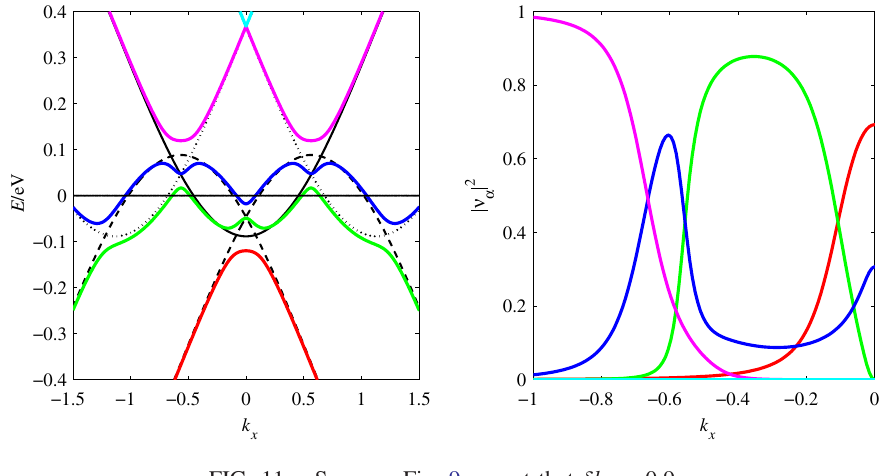
FIG. 11. Same as Fig. 9 except that δ k y ¼ 0 . 9 .